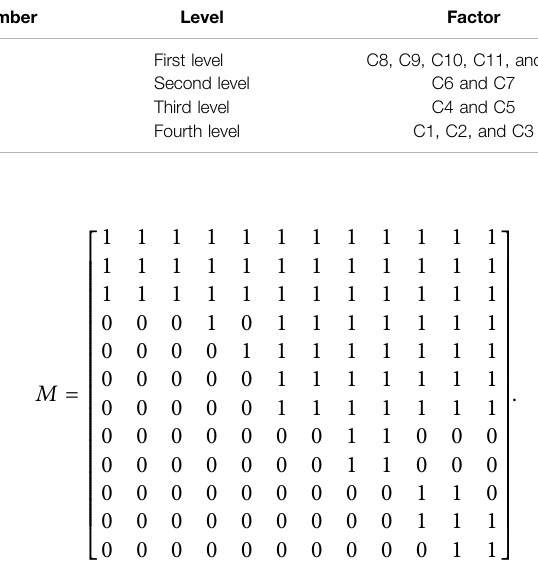
TABLE 2 | Relationship between the restrictive factors of charging piles in the park.